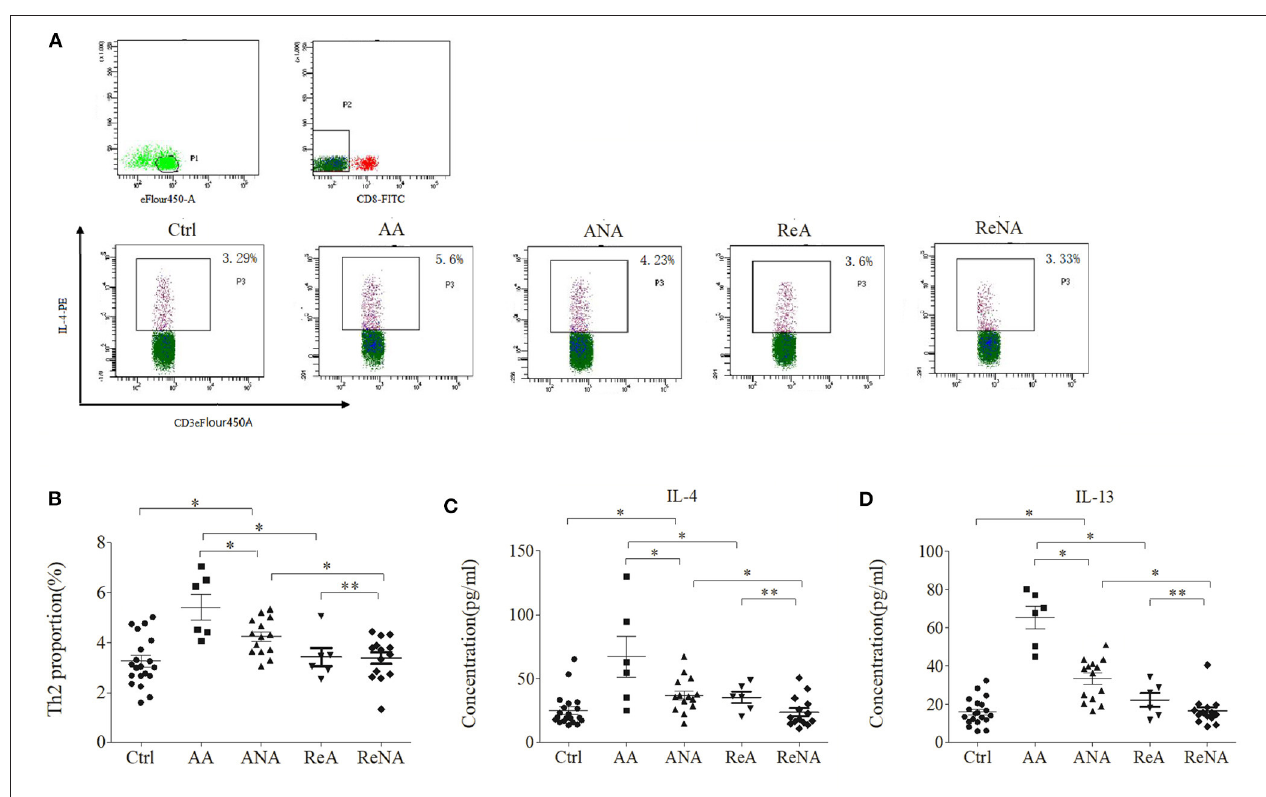
FIGURE 2 | Children with INS have increased levels of Th2 cells and Th2-related cytokines. (A) Flow cytometric analysis of Th2 cells. (B) Percentages of Th2 cells. (C) Plasma concentrations of IL-4. (D) Plasma concentrations of IL-13. * P < 0.05 and ** P > 0.05.